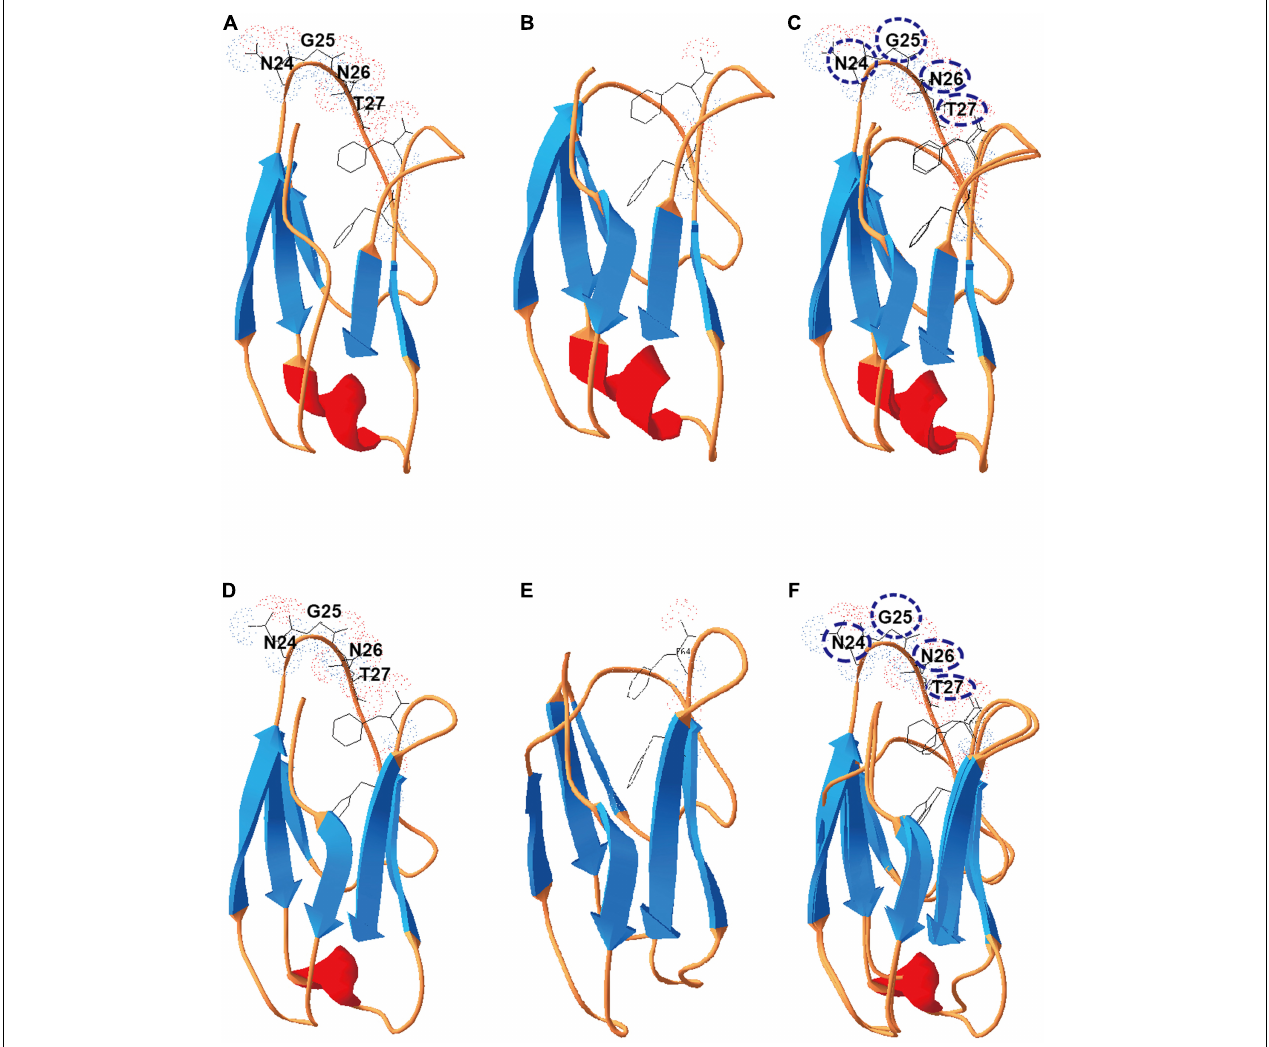
FIGURE 2 | Deletion of the conserved motif (NGNT) may lead to a conformational change of the X2 module. (A) The structure of the X2-N module protein; (B) the structure of (cid:49) X2-N module in which the conserved NGNT residues were deleted. (C) Structures overlapping between X2-N and (cid:49) X2-N modules. (D) The structure of the X2-C module protein; (E) the structure of (cid:49) X2-C module in which the conserved NGNT residues were deleted; (F) structures overlapping between X2-C and (cid:49) X2-C